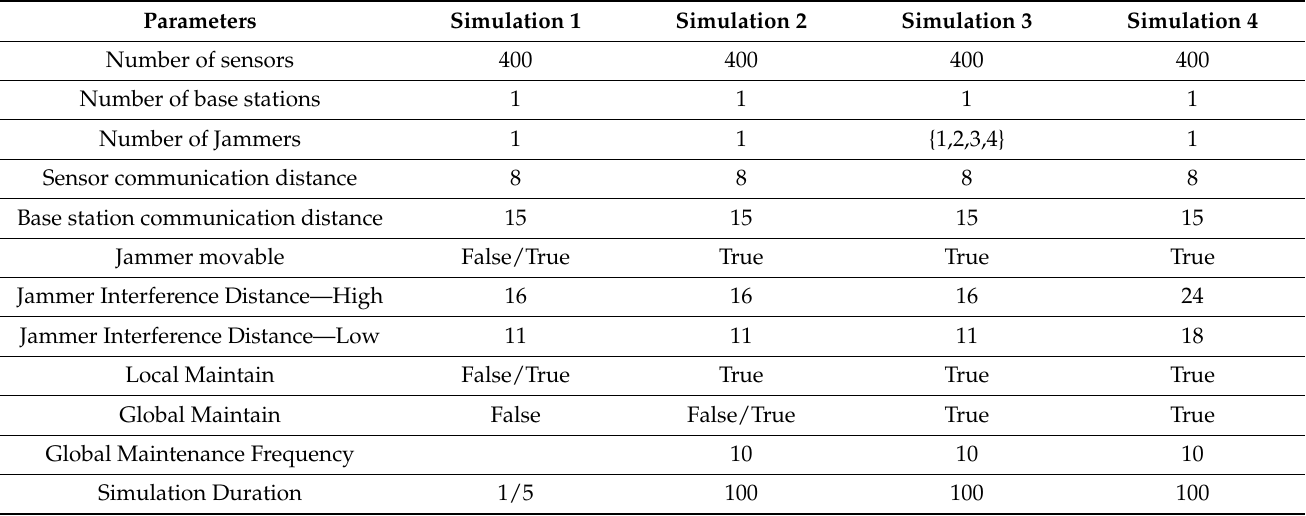
Table 1. Parameter